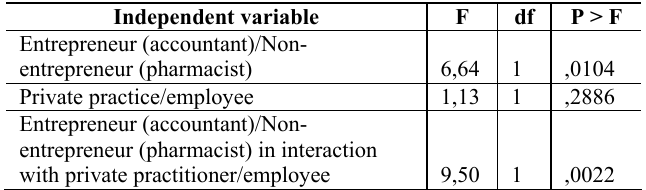
Table 1: Results of analysis of variance with the economic innovation sub-scale as dependent variable